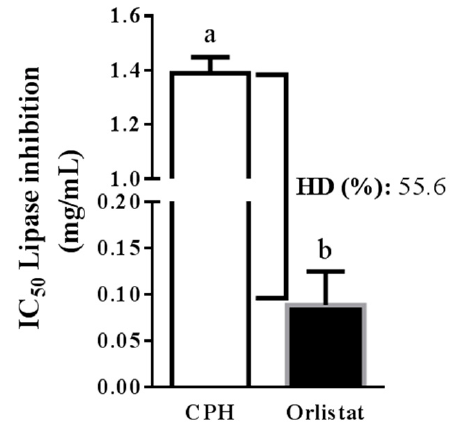
Figure 2. IC 50 (concentration needed to inhibit 50% of enzyme activity) of cocoa protein hydrolysate (CPH) and orlistat against pancreatic lipase. HD: hydrolysis degree. The data are represented as mean ± standard error of the mean (SEM) of n = 3. a, b indicate significantly different values ( p < 0.0001).